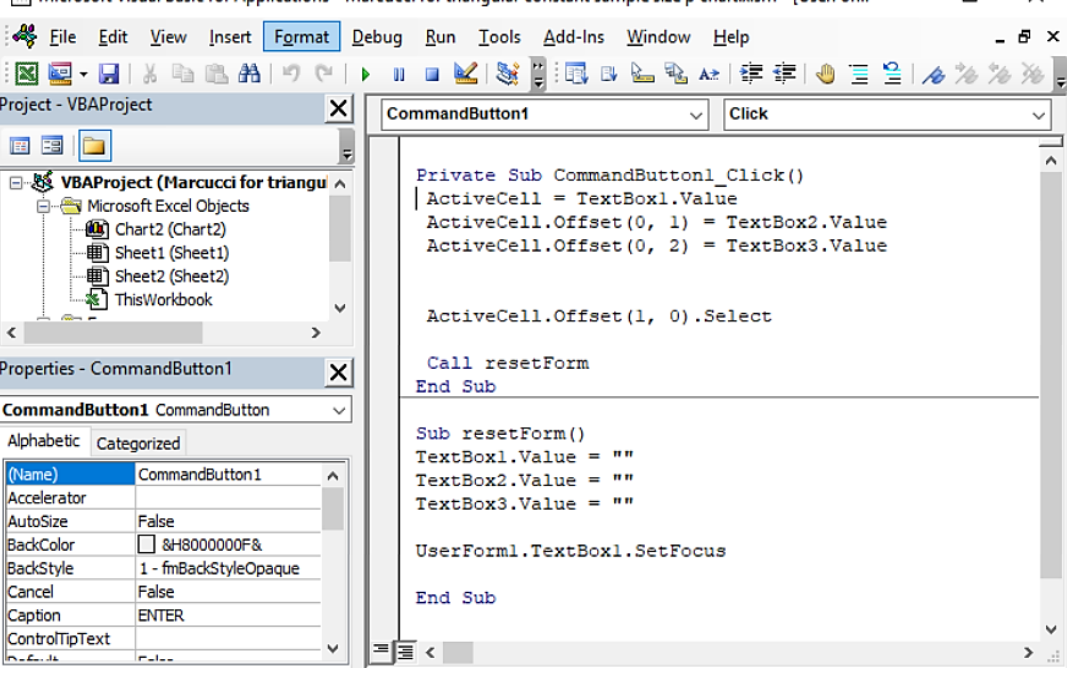
Figure 9. Visual Basic Coding Against the Enter Command